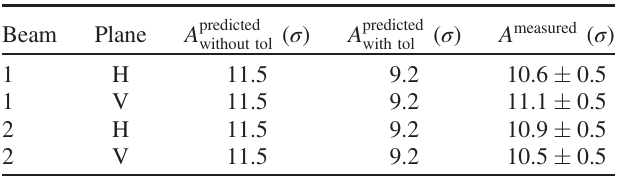
TABLE I. Measured and predicted bottleneck aperture values for the 2017 top energy LHC optics for both beams and planes. The predicted values had been computed without and with measured tolerances [4]. Beam Plane